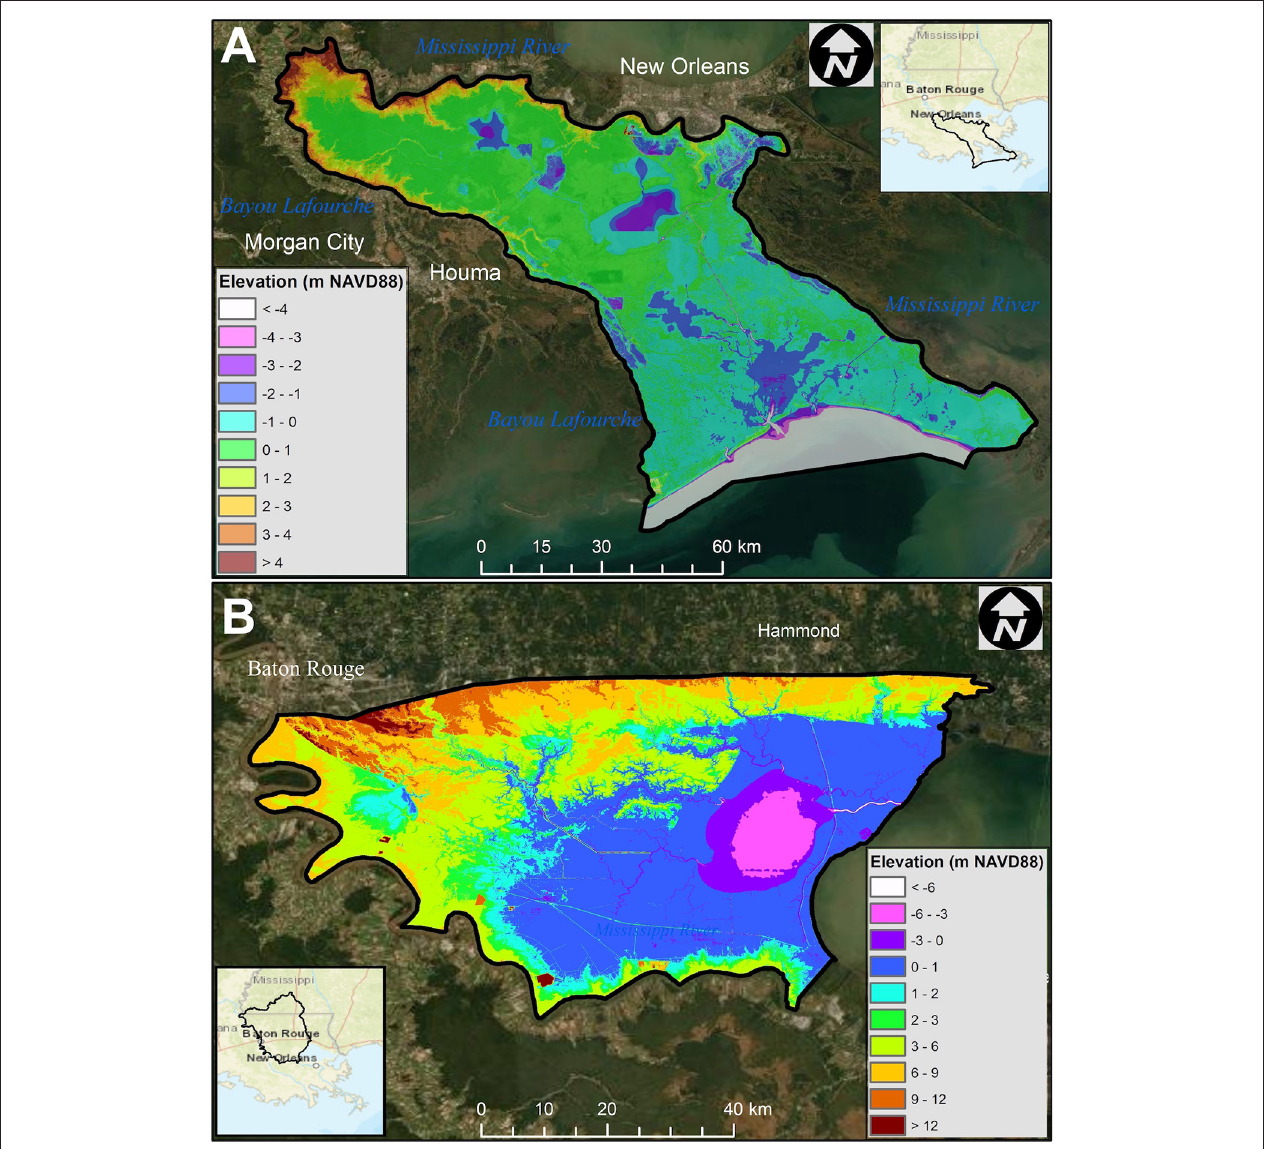
FIGURE 1 | Location of the study area within southeastern Louisiana. Topographic and bathymetric elevations (m,NAVD88) are shown for the (A) Barataria watershed and the (B) Lake Maurepas watershed. Service Layer Credits: Esri, Maxar, GeoEye, Earthstart Geographics, CNES/Airbus DS, USDA, USGS, AeroGRID, IGN, and the GIS User